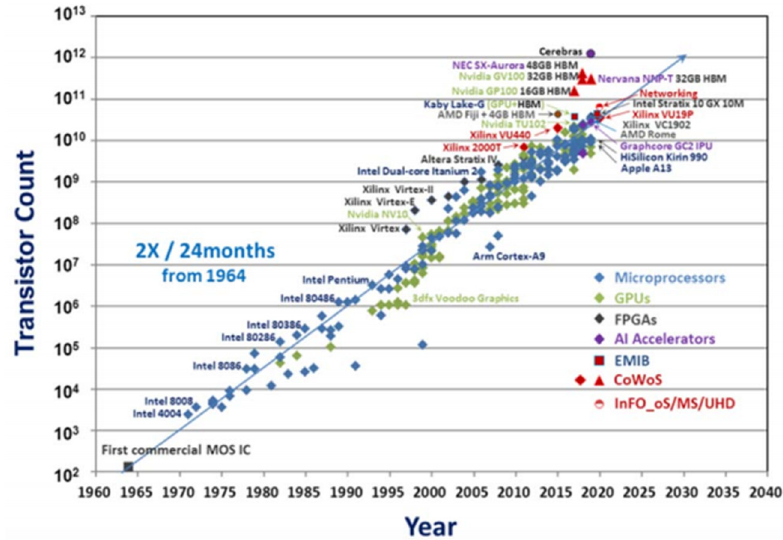
Figure 6: Evolution of transistor count according to Moore ’ s law [ 142 ] .